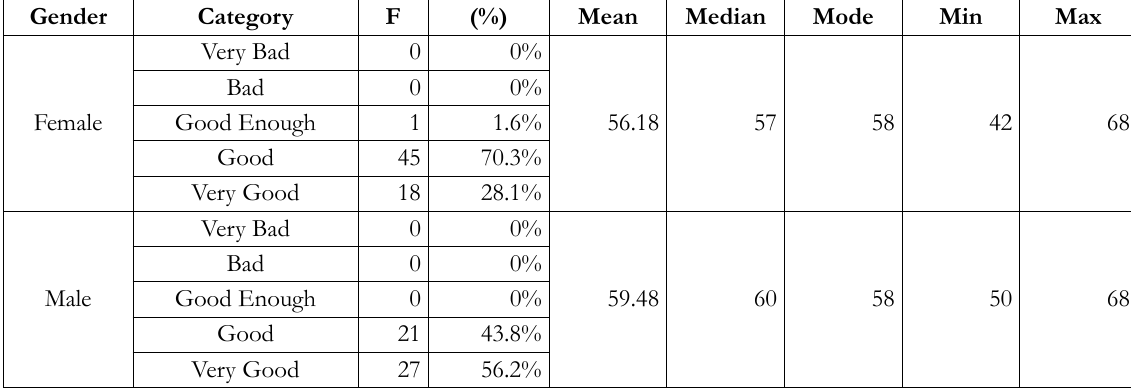
Table 11. Character Description of Seventh Grade